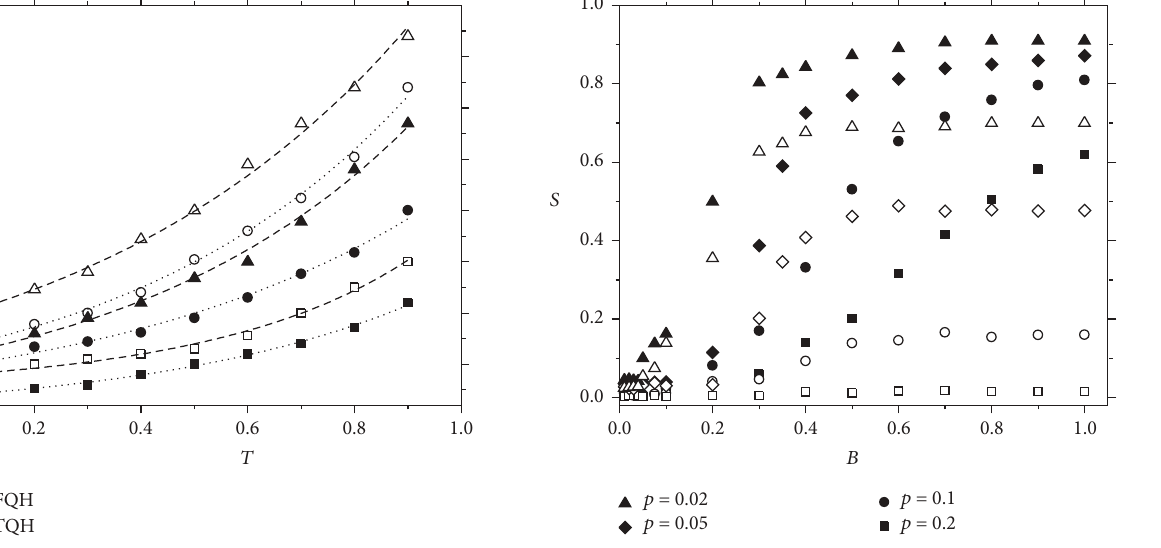
Figure 6: Average degree of ordering for switched-on and after- wards switched-off external ordering field 𝐵 for different values of 𝑝 . Full symbols: 𝐵 is switched on. Empty symbols: 𝐵 is switched off. TQH, 𝑊 = 3 , 𝑇 = 05 , and 𝐿 = 70